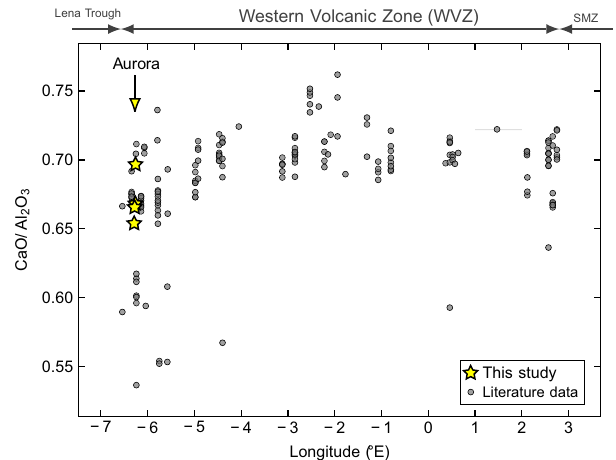
Fig. 5| Changesinbasalt CaO/Al2O3compositionsalongtheWestern Volcanic Zone (WVZ) of the Gakkel Ridge between the Lena Trough and the Sparsely Magmatic Zone (SMZ). Lower ratios towards either end of the WVZ compared to its center can be attributed to (i) lower degrees of partial melting of the mantle causing less clinopyroxene to contribute CaO to the melt and resulting in reduced melt production 51 , and/or (ii) high-pressure crystallization of clinopyroxene, lead- ingtoCaOdepletioninthemelt,withinathicklithosphere 52 .Ineithercase,thedata supportarestrictedthicknessofvolcaniccrustoverlyingthelithosphericmantleat the Aurora site in the western WVZ (location denoted by vertical arrow). Yellow stars:thisstudy. Gray circles:glassanalysesdownloadedfrom the PetDBPetrology DataBase